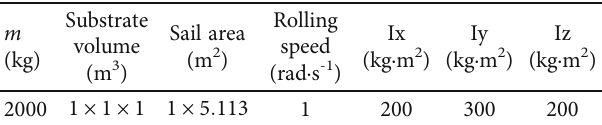
Table 2: Spin target